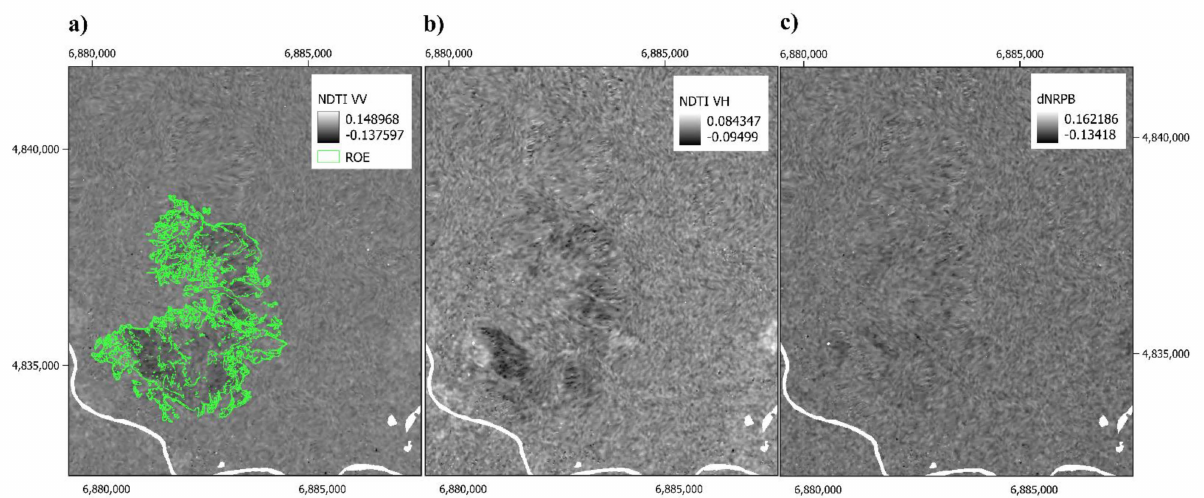
Figure 6. Comparison of SAR-derived index differences (NDTI—Normalized Differenced Temporal Index for both ( a ) vertical-vertical (VV) and ( b ) vertical-horizontal (VH) polarizations; ( c ) dNRPB— difference of Normalized Ratio Procedure between Bands) alongside the delineation of the Ref- erence Observed Event (ROE) [45] for the Monte Pisano fire (Italy) (coordinate reference system: RDN2008/Italy zone (N-E)).